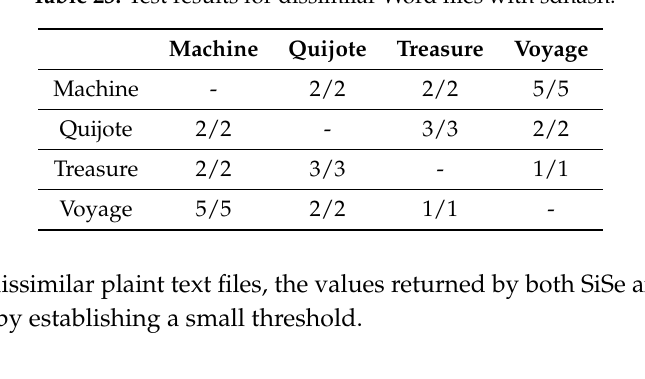
Table 23. Test results for dissimilar Word files with